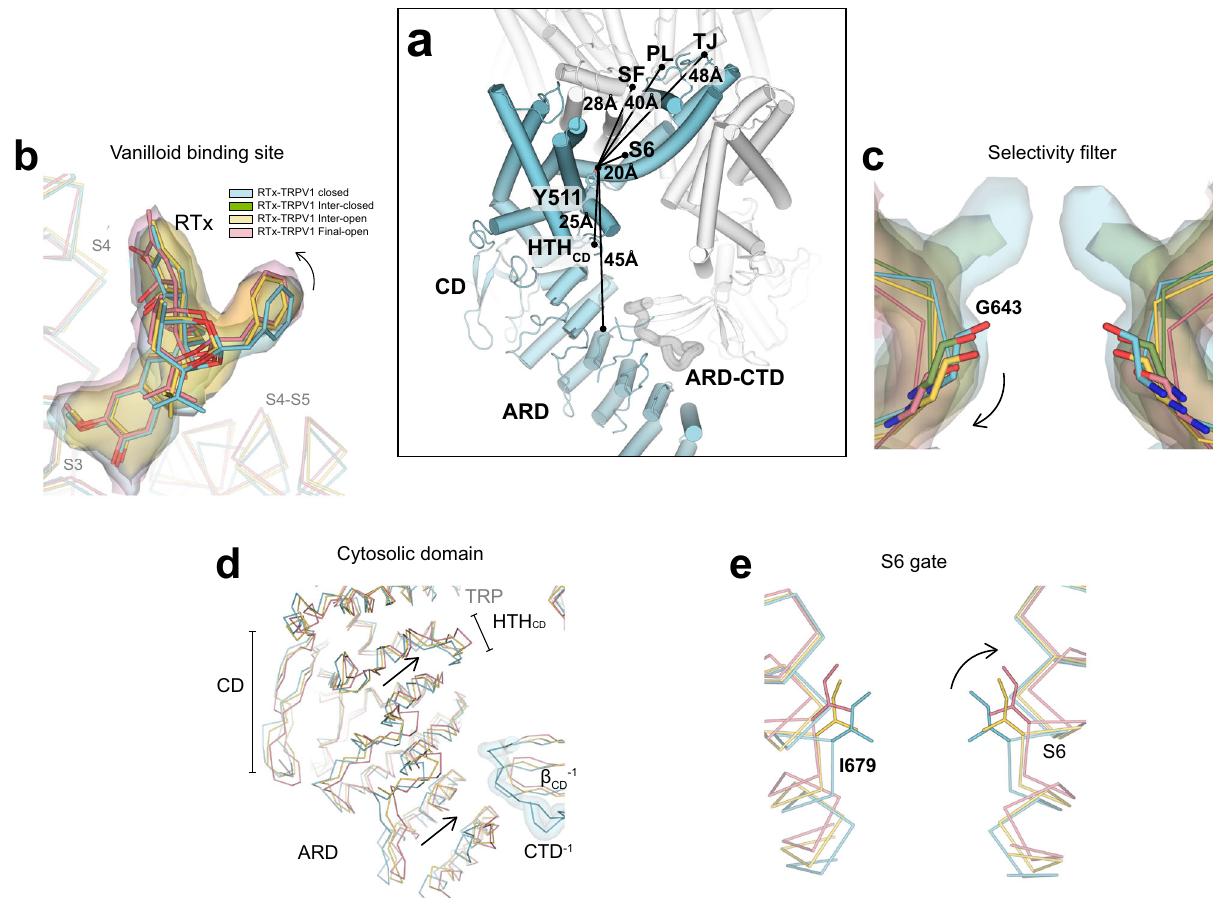
Fig. 5 RTx-dependent long-range conformational changes in TRPV1. a Cylinder representation of TRPV1 in turquoise (one subunit) and gray (the rest of the channel). The approximate distances from the RTx binding site (reference residue Y511) to subdomains are shown. b The cryo-EM densities (surface) and respective models (sticks) depicting close-up views of the vanilloid binding sites in TRPV1 C, RTx (skyblue), thresholding 0.19, TRPV1 IO, RTx (yellow), thresholding 0.04, and TRPV1 O, RTx (pink), thresholding 0.033. c The cryo-EM densities (surface) and respective models (sticks) depicting close-up views of the selectivity fi lter in TRPV1 C,RTx (skyblue), thresholding 0.19, TRPV1 IC,RTx (green), thresholding 0.04, TRPV1 IO,RTx (yellow), thresholding 0.1, and TRPV1 O,RTx (pink), thresholding 0.033. d – e Close-up view of the overlays of TRPV1 C,RTx (skyblue), TRPV1 IO,RTx (yellow), and TRPV1 O,RTx (pink) regarding the cytoplasmic domain, and S6 gate e ,